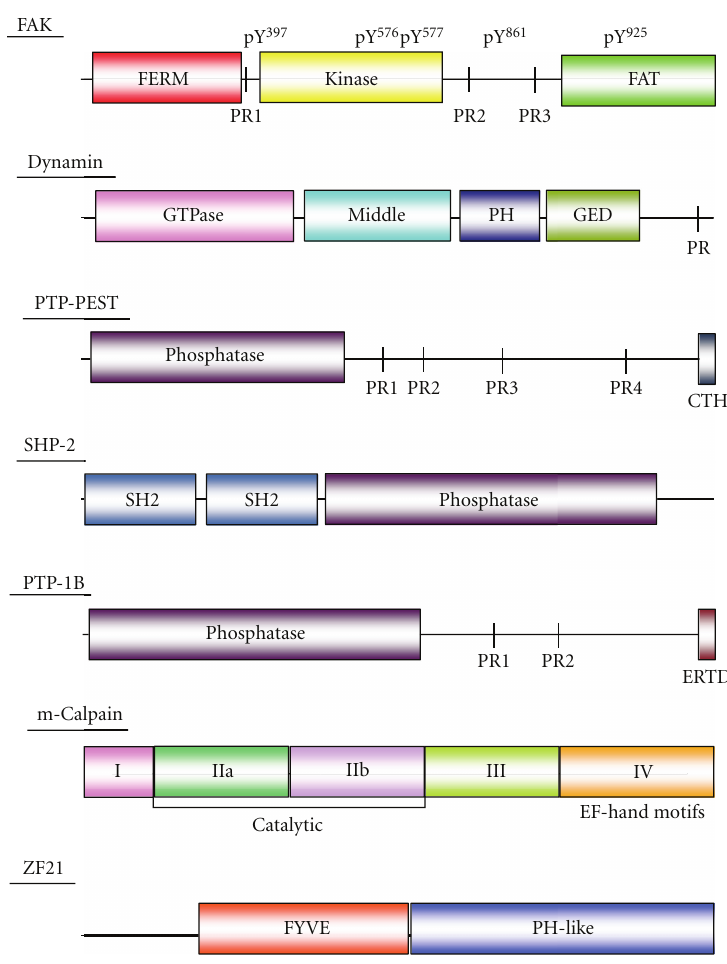
Figure 4: Domain structures of FA disassembly factors. FAK: FERM (protein 4.1, ezrin, radixin, and moesin homology), PR (proline-rich motif), FAT (focal adhesion targeting), pY (phosphorylated tyrosine), Dynamin: PH (pleckstrin homology), GED (GTPase e ff ector domain), PTP-PEST: PR (proline-rich motif), SHP-2: SH2 (src homology 2 domain), PTP-1B: PR (proline-rich motif), ERTD (endoplasmic reticu- lum-targeting domain), m-Calpain: I (possible autoinhibitory region), IIa and IIb (protease domain), III (putative phospholipid-binding sites), and IV (the region containing 4 EF-hand motifs), ZF21: FYVE (Fab1, YOTB, Vac1, and EEA1), PH-like (pleckstrin